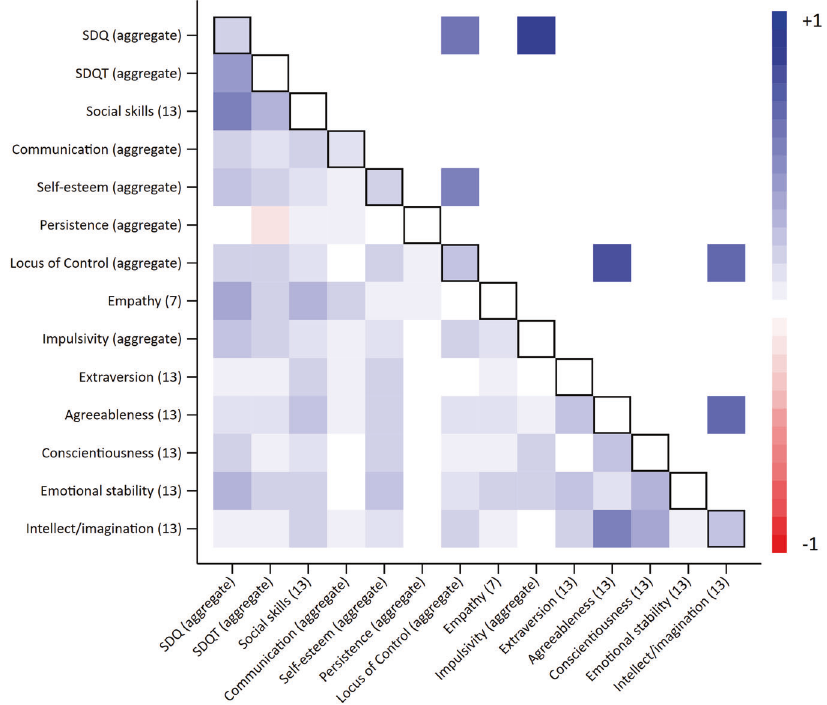
Fig. 2 Heritability, phenotypic correlations and genetic correlations of aggregate noncognitive skills. Age (years) in parentheses; “ mean ” indicates aggregate measure of noncognitive skills measured more than once. Values on the diagonal represent univariate heritabilities; values below the diagonals represent phenotypic correlations; values above the diagonal represent genetic correlations. Multiple testing was handled using a False Discovery Rate threshold of 5%. Empty cells display correlations that fell below the False Discovery Rate threshold. Black outline boxes indicate the same skills measured at different occasions. SDQ: parent reported strengths and dif fi culties questionnaire; SDQT: teacher reported strengths and dif fi culties questionnaire. See Supplementary Tables 4 and 5 for full